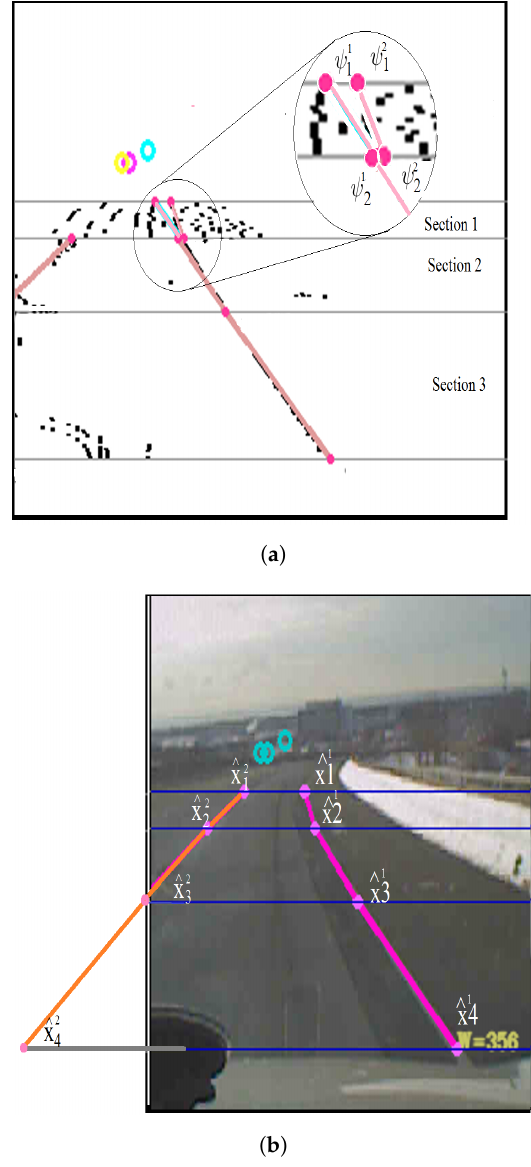
Figure 5. An example of control point estimation/correction and extended line segments. ( a ) Con- trol point estimation/correction based on measurements; ( b ) grouped line segments based on the